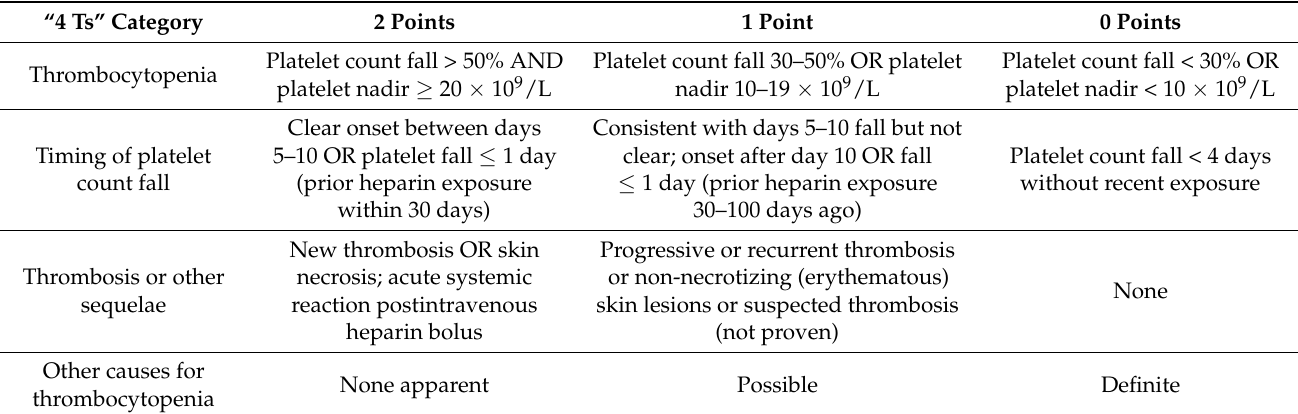
Table 1. Estimating the pre-test probability of HIT: the “4